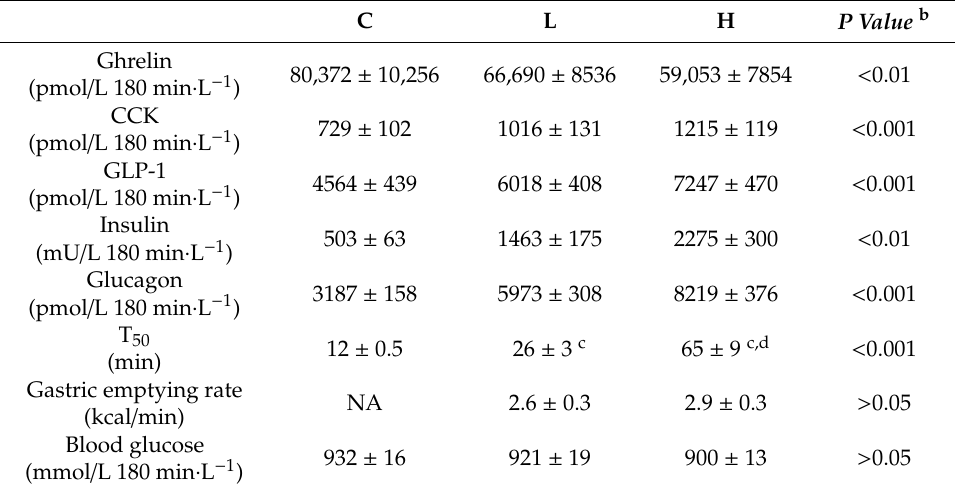
Table A3. Plasma gut hormone responses (AUCs 0–180 min ), gastric emptying and the amount and total energy consumed at a bu ff et meal, in response to the test drinks containing either 0 g (C), 30 g (L) or 70 g (H) of pure whey protein dissolved in varying amounts of distilled water, diet cordial, and sodium chloride (all 450 mL and 88 mOsm / L) a